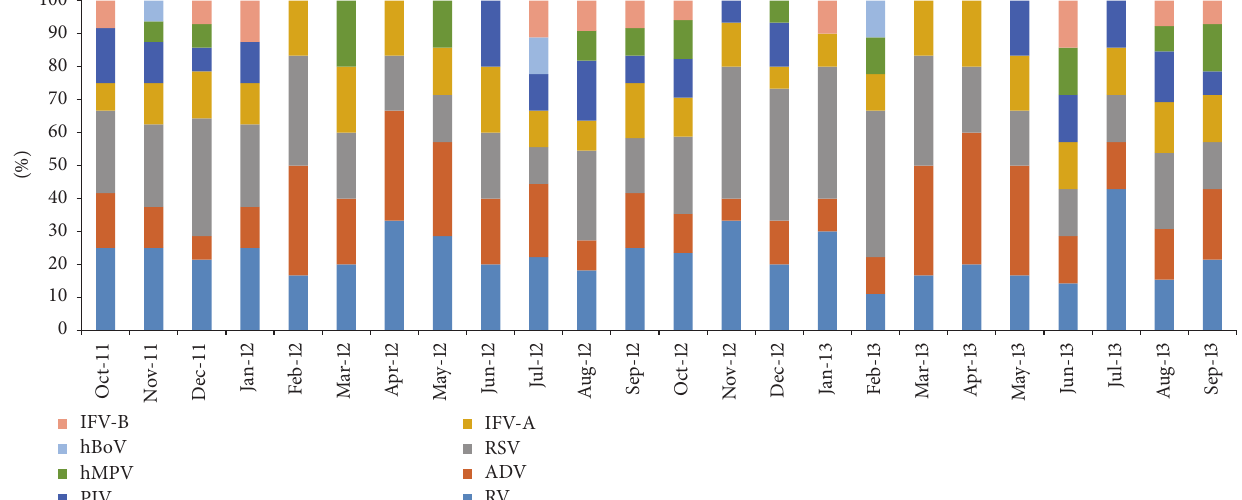
Figure 3: The distribution of viruses by months of recruitment.